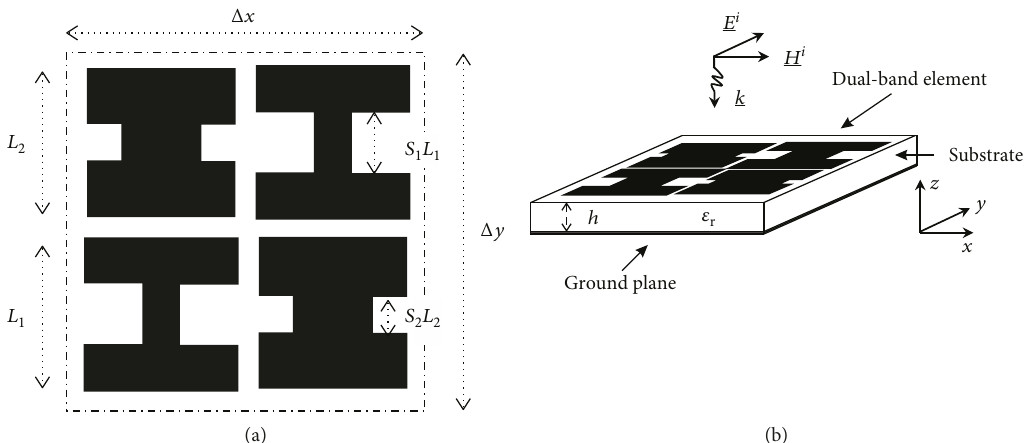
Figure 1: Unit cell layout: (a) top view and (b) 3D view and reference system.